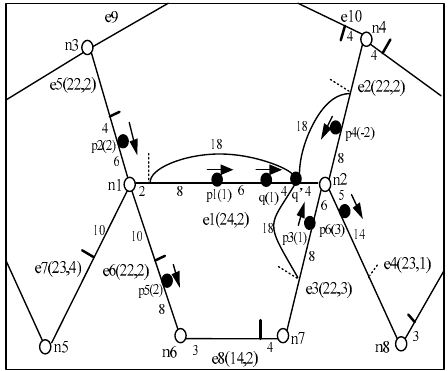
Figure 7. An example of monitoring range.